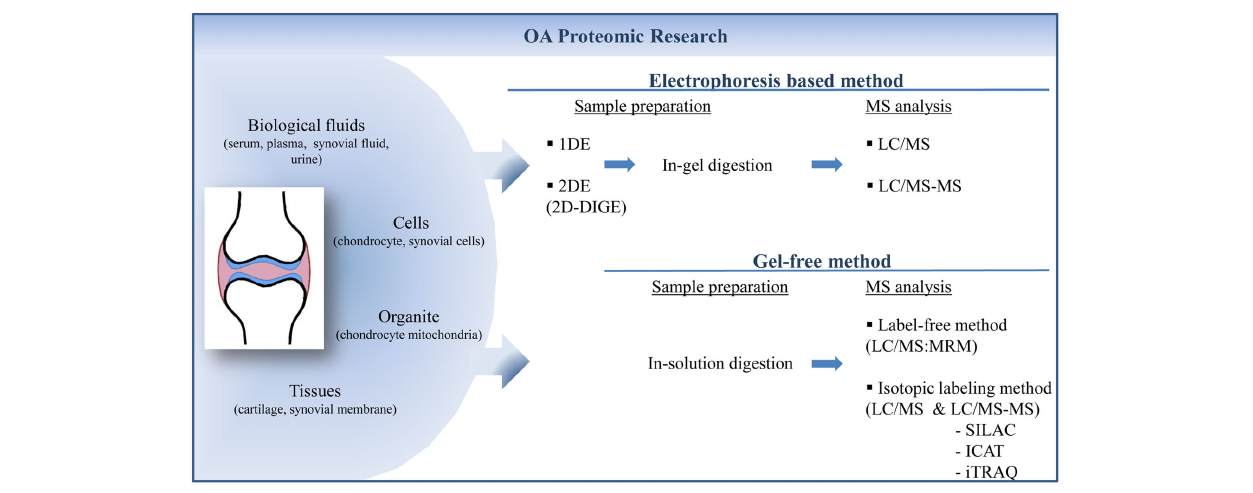
FIGURE 1 | Proteomic strategies to quantify and identify biomarkers of osteoarthritis from different kind of samples. Proteins extracted from samples could be separated by electrophoresis in one (1DE) or two (2DE) dimensions. Proteins are labeled before or after gel migration to perform quantification. After in-gel digestion proteins are identified by mass spectrometry. Gel-free methods involve the separation of digested peptides